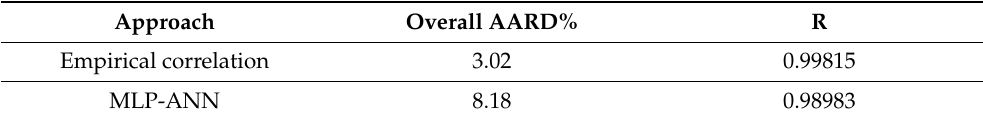
Table 4. Comparison between the performance of empirical correlation and MLP-ANN with the same number of adjustable parameters.